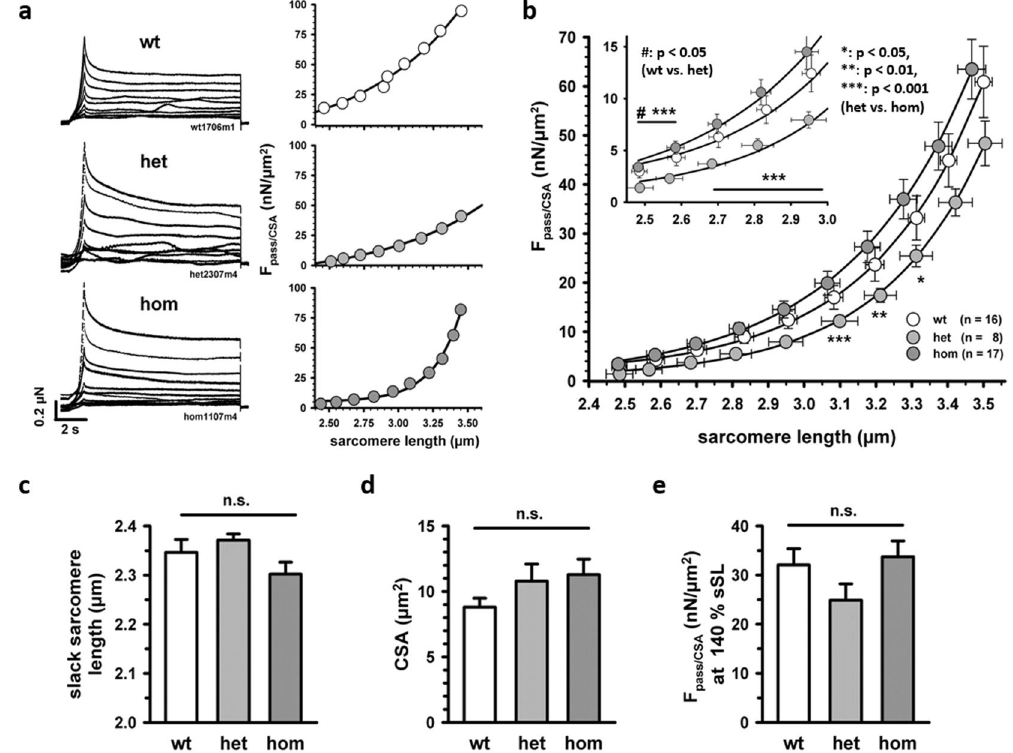
Figure 8. Passive mechanical properties of myofibrillar bundles from soleus muscles of young Des R349P knock-in mice. ( a ) Exemplary traces of myofibrillar bundles stretched under relaxing conditions (pCa 8) at constant speed for 1 s from 8 to 180% of L 0 . ( b ) Mean data ± SEM of actual sarcomere lengths and passive tension, i.e. passive force normalized to the cross-sectional area of the myofibrillar bundle (F pass /CSA), from 16 bundles of wt, 8 bundles of het and 17 bundles of hom Des R349P mice. The averaged group data for each genotype is fitted to a worm-like chain model of entropic elasticity (solid lines). No significant difference between bundles from hom and wt mice was found while bundles from het mice had significantly lower passive tension at moderate stretch compared to bundles from hom mice. * p < 0.05, ** p < 0.01, and *** p < 0.01, indicated by Student’s t-test. At low stretch amplitude, bundles from het mice exhibited slightly lower tension than wt bundles ( # p < 0.05). ( c ) Slack sarcomere length, ( d ) cross-sectional area, and ( e ) passive tension at 140% L 0 of the myofibrillar bundles were not different among the three different genotypes